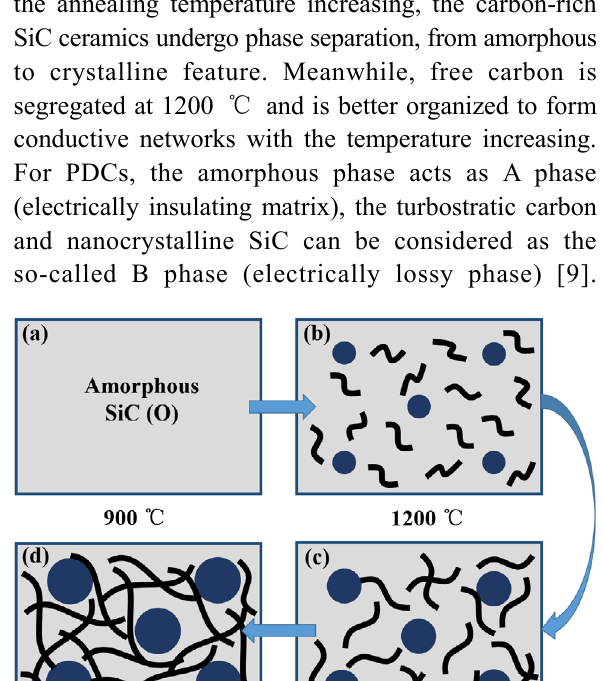
Fig. 5 (a) Bright field lattice images (insets: selected area electron diffraction) and (b) HRTEM images of PAD-2 derived ceramics annealed at different temperatures (insets: diffraction patterns obtained by Fourier filtered transformation).